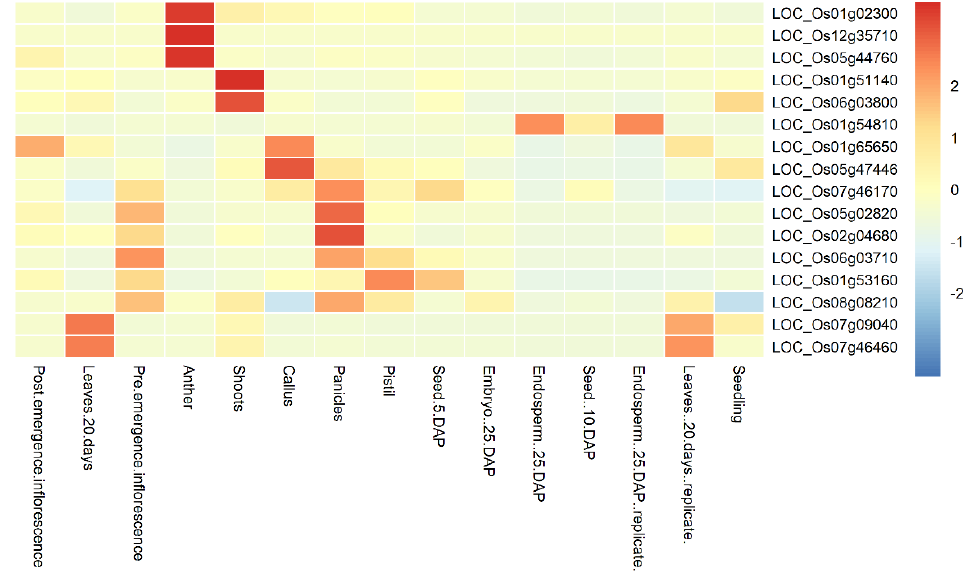
Figure 3. Heatmap showing FPKM values of a subset of candidate genes for the identified PH traits. The heatmap reflects the expression in different organs or tissues of rice.